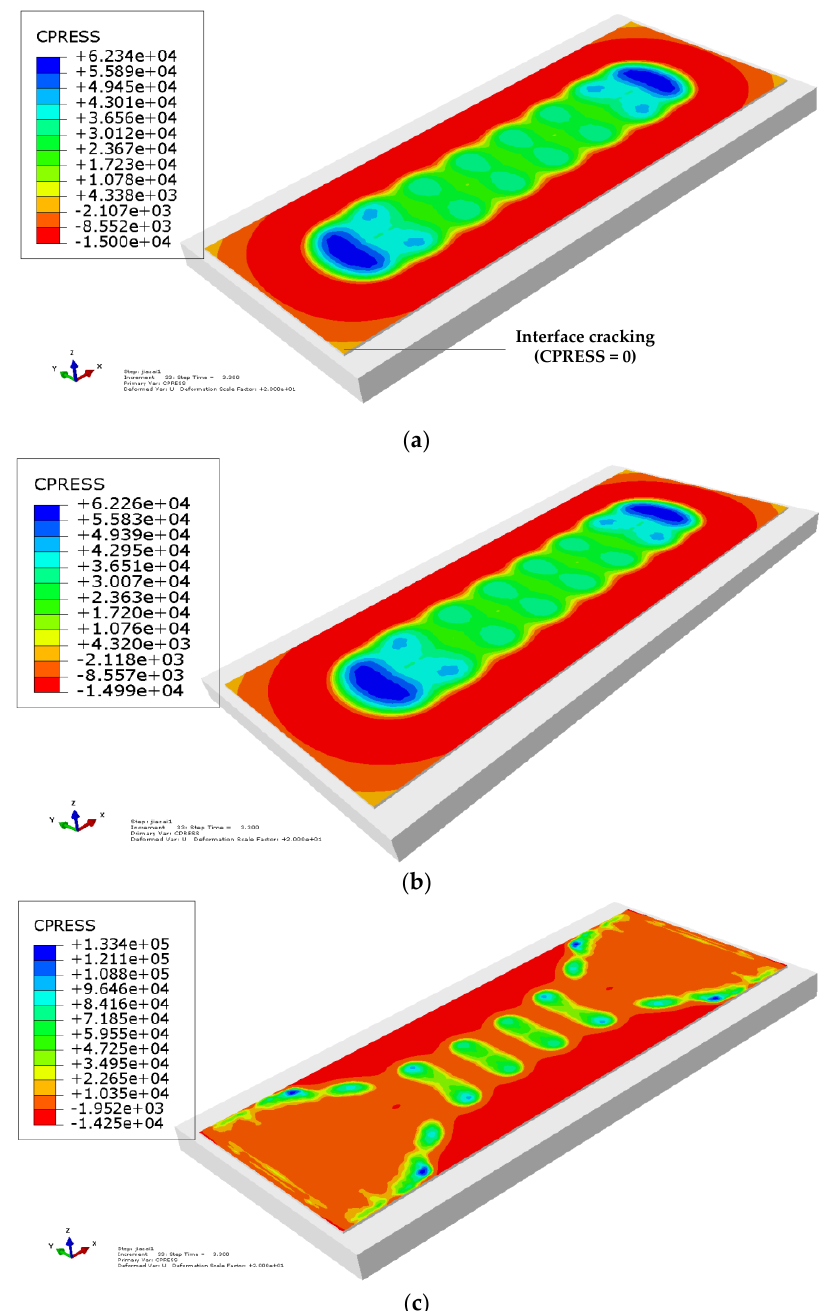
Figure 23. I nterface normal stresses (CPRESS) between slab and CA mortar layer when interface crack happens: ( a ) the model proposed in the paper, ( b ) PPR model, and ( c ) cohesive zone model in ABAQUS.